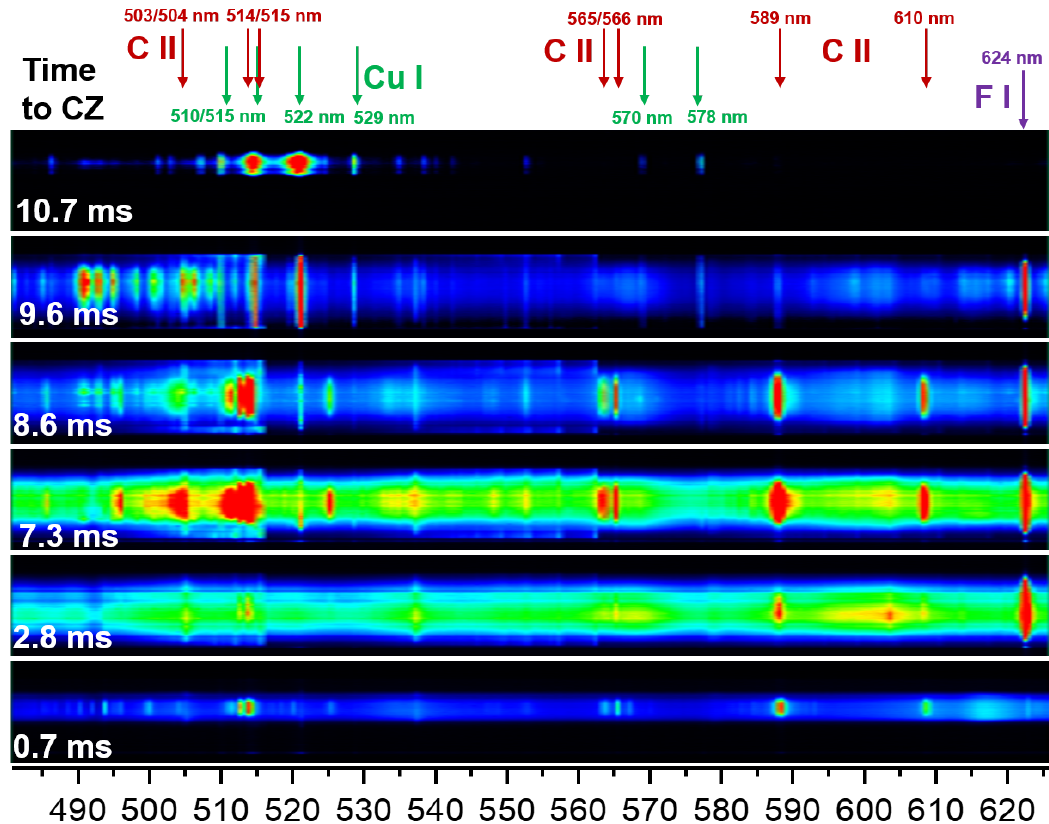
Figure 5. 2D-optical emission spectroscopy (OES) frames acquired at selected time points during one discharge by video spectroscopy with setup (b). From top to bottom: Ignition phase dominated by atomic Cu I lines from wire, transition to ablation-dominated arc with ionic C II and atomic F I lines from PTFE and close to CZ only C II from CO 2